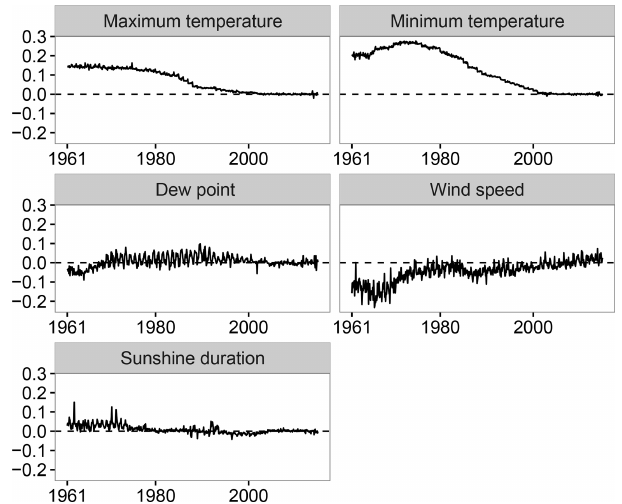
Figure 6. Temporal evolution of the differences between the mean regional values before and after homogenization.